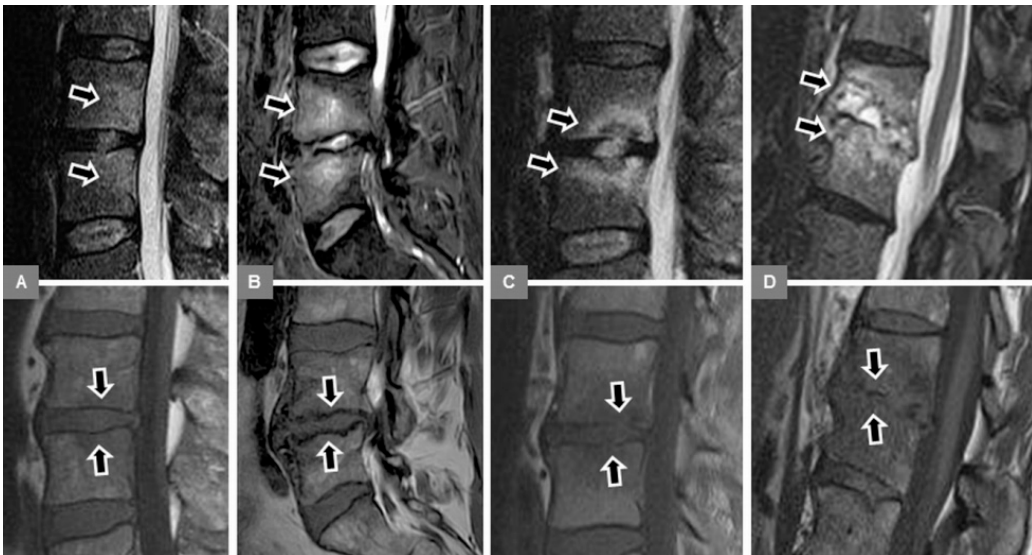
Figure 5. Evaluation of the vertebral endplate contour (bottom row of unenhanced sagittal T1-w images, arrows) in different patients with vertebral bone marrow edema (top row of sagittal STIR images, arrows), resulting from MT1 or spondylodiscitis. ( A ) A 54-year-old male patient with early spondylodiscitis and normal endplates at L3/4. ( B ) A 53-year-old male patient with Modic type 1 and irregular, but intact endplates and marked T1-w hypointense bony sclerosis, representing additional Modic type 3 changes at L4/5. ( C ) A 55-year-old male patient with early spondylodiscitis and blurred, discontinuous endplates at L3/4. ( D ) A 63-year-old male patient with advanced spondylodiscitis and endplate destruction with height decrease at Th12/L1.